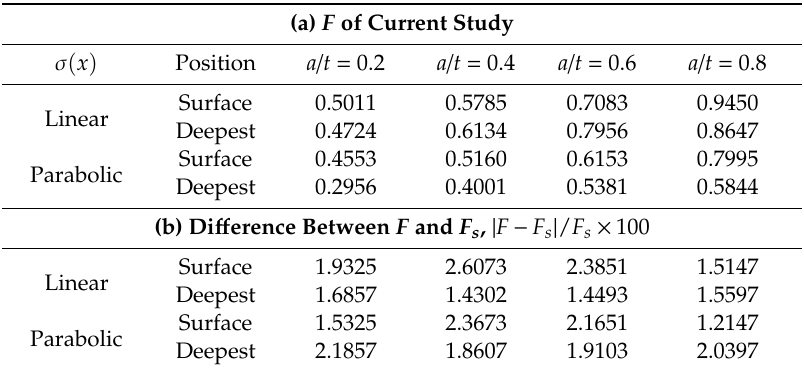
Table 2. Comparison of boundary correction factors (BCFs) ( F ): current study vs. results F s in reference [11], for a / c =